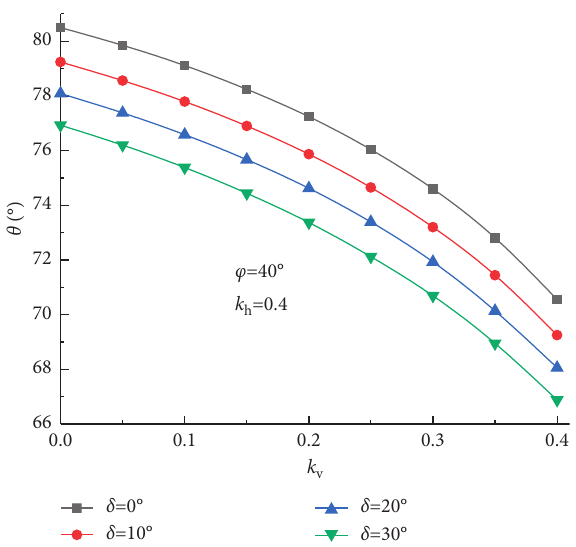
Figure 8: θ curve of variation with (k)v and δ .